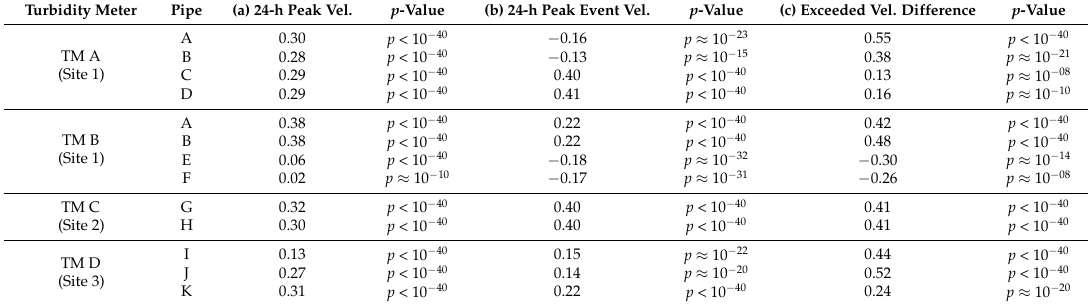
Table 5. Spearman’s rank correlation coefficients and associated p -values for three sets of correlations: ( a ) 24-h preceding peak velocities of each turbidity observation correlated with those turbidity observations; ( b ) 24-h preceding peak velocities of each turbidity event correlated with the turbidity observations of that event; ( c ) the difference between the 24-h preceding peak velocity and the 30-day preconditioned threshold of each turbidity event correlated with the turbidity observations of that event. Turbidity Meter Pipe (a) 24-h Peak Vel. (b) 24-h Peak Event